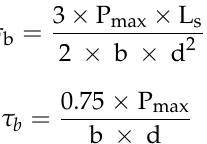
Figure 2. Specimens made for bending and shear strength tests ( a ) unsaturated polyester composites, ( b ) epoxy compo- sites, and ( c ) novolac composites.